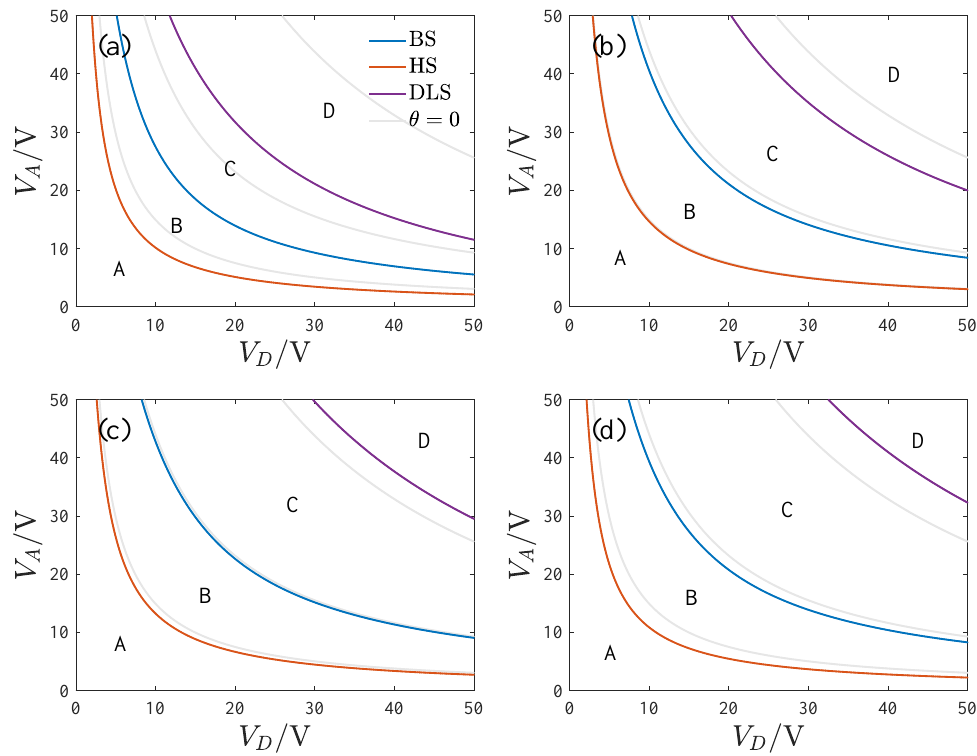
Figure 15. The transition sets corresponding to different inclination angles, ( a ) θ = − 2 ◦ , ( b ) θ = − 1 ◦ , ( c ) θ = 1 ◦ , ( d ) θ = 2 ◦ .